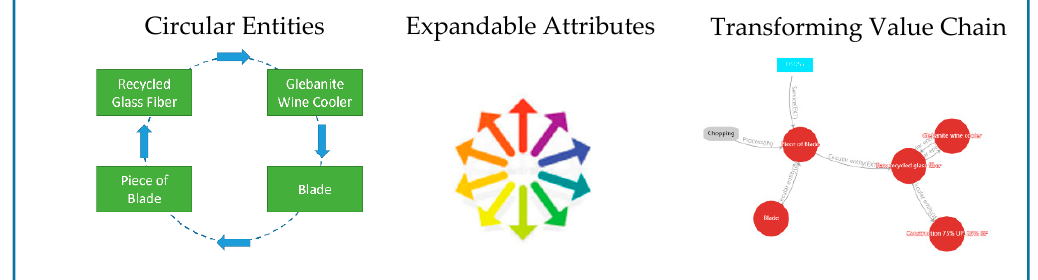
Figure 4. FiberEUse pivotal